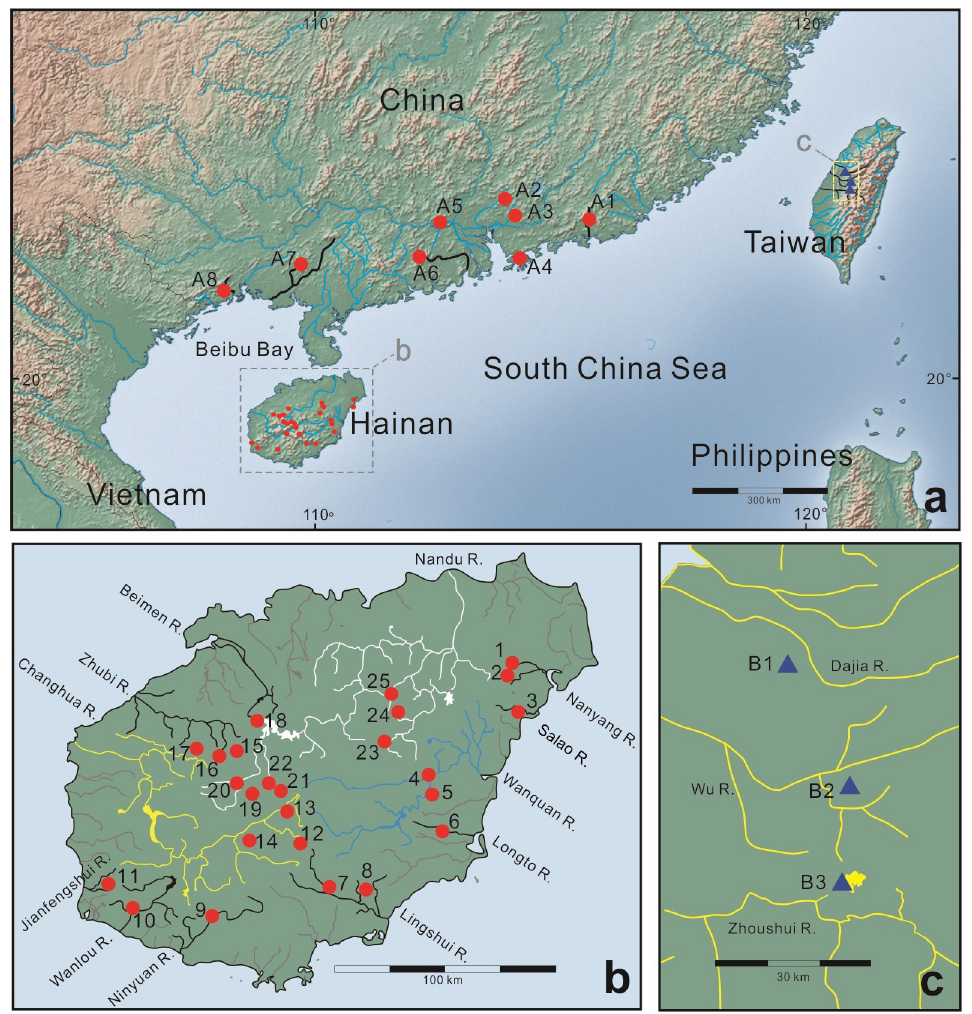
Fig 1. Locations of sampling sites in this study. Site numbers and river systems are listed in Table 1. a, southern mainland China sampling sites for Aphyocypris normalis (solid red circles); b, Hainan Island sampling sites for A . normalis (solid red circles). Three major river systems of Hainan Island are identified by different colors: white–the Nandu River; blue–the Wanquan River; yellow–the Changhua River; c, Taiwan sampling sites for A . moltrechti as the outgroup (solid blue